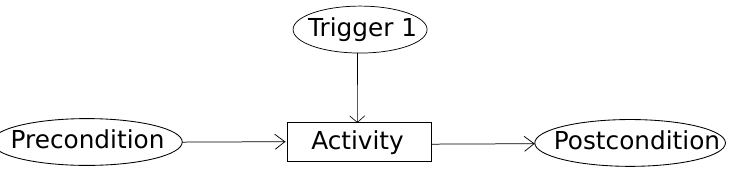
Figure 7. Mapping a behavioral interface to a CPN model (Adapted from